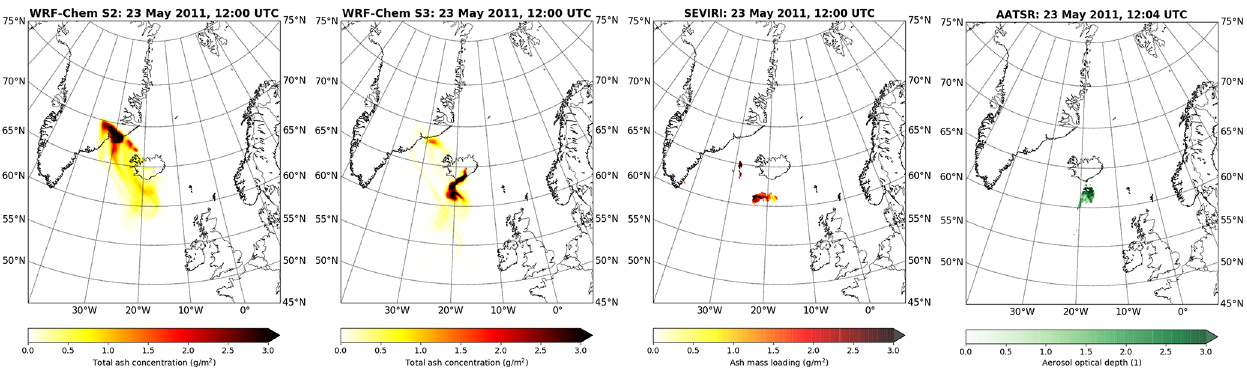
Figure 7. Total ash columns from WRF-Chem simulations (S2 and S3), SEVIRI ash mass loading and AOT from AATSR on 23 May 2011